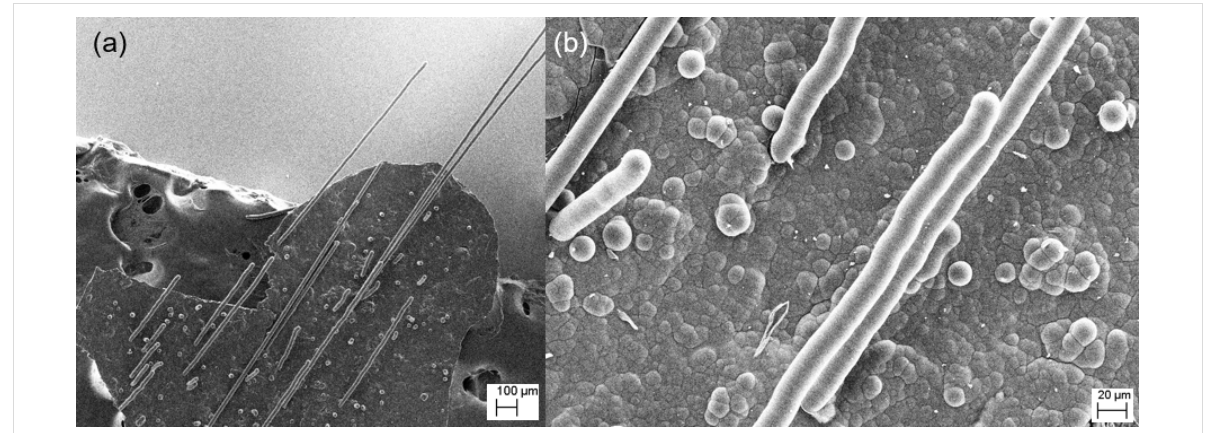
Figure 1: (a) SEM overview image showing a number of glassy carbon microneedles, (b) SEM detail image of glassy carbon microneedles, nucle- ating microneedles, and nucleation “blisters”.